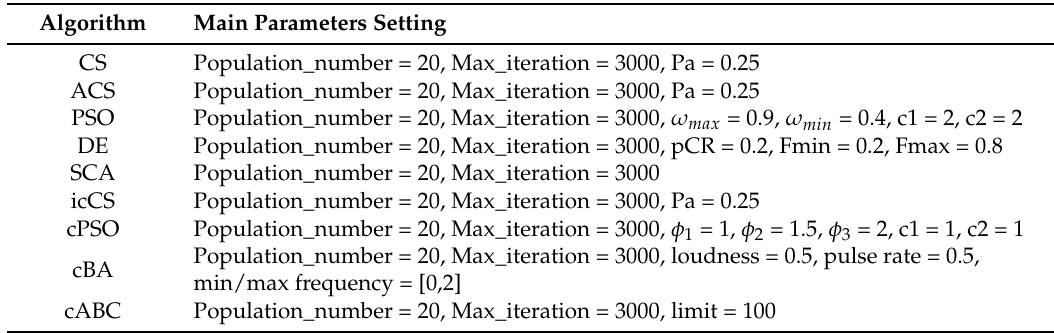
Table 1. Parameters setting of each algorithm.